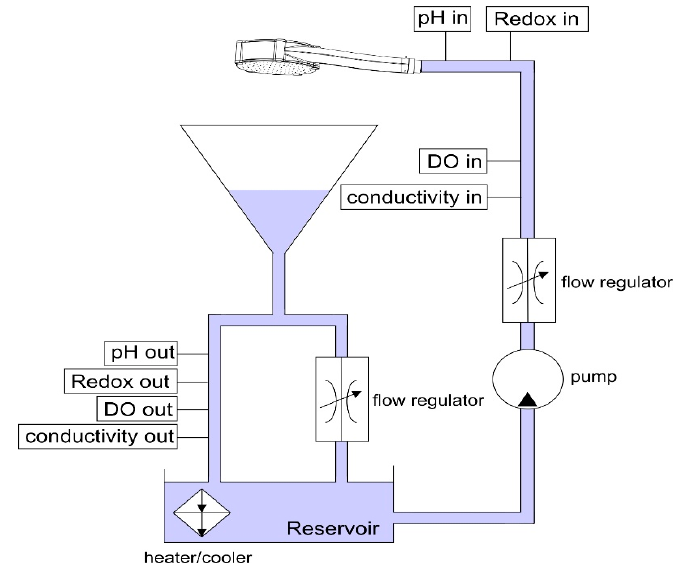
Figure 2. Recirculating setup for measuring chemical parameters for either the normal or the vortex showerhead.